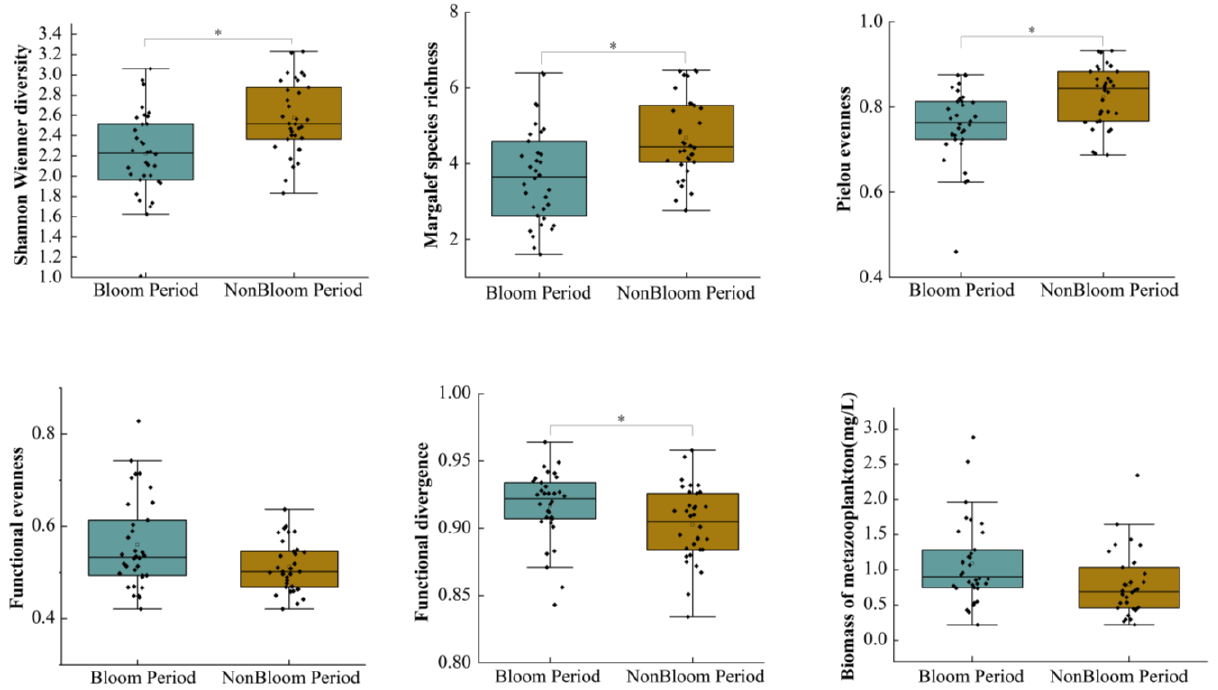
Figure 2. Variations in species diversity and functional diversity (FDiv, FEve) of metazooplankton during cyanobacterial bloom period and non-bloom period. * p < 0.05.